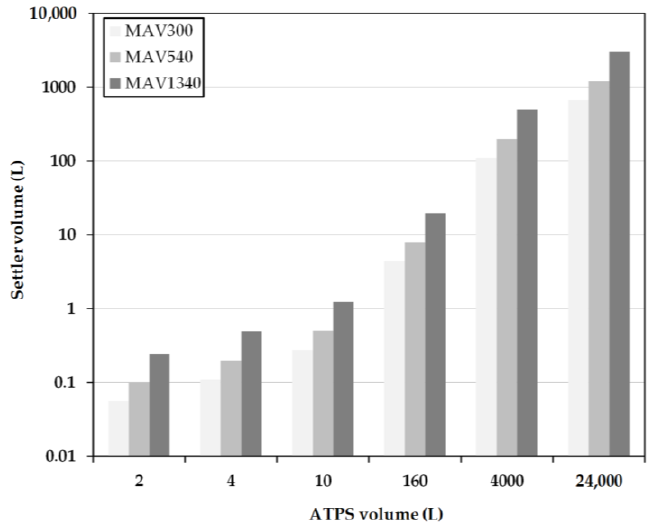
Figure 9. Settler volume as a function of residence time for different system scales obtained for the MAV method. MAV: minimum-apparatus-volume. MAV300, MAV540 and MAV1340 represent separation times of 300, 540 and 1340 s.